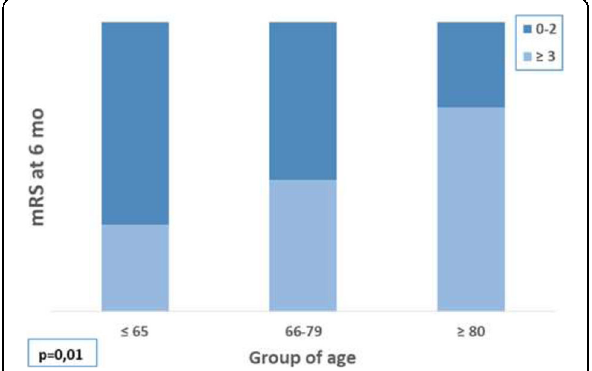
Graph 1 (abstract 0360). See text for description